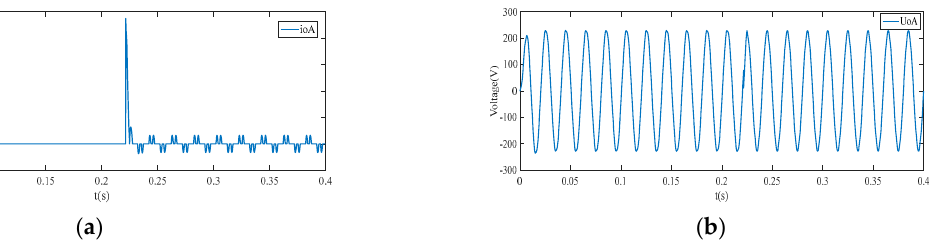
222 ms, the UPS is imposed on instantaneous rectifier load, 𝐶 (cid:3045)(cid:3030) = 9900 µF, 𝑅 (cid:3045)(cid:3030) = 16 Ω . It is obvious that when the pulse type load is input, the current waveform does not change Figure 10. THD of output phase A voltage of UPS ( a ) UPS with current-limiting method, ( b ) UPS with dynamic switching method, ( c ) UPS with VSG control and dynamic switching method. ally decreases with the increase of load.